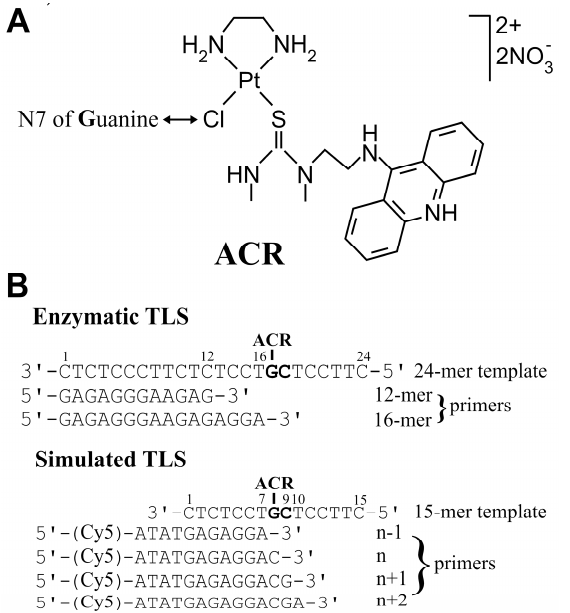
Figure 1. ( A ) Structure of the investigated platinum conjugate ACR, [PtCl(en)(L)](NO 3 ) 2 (en = ethane- 1,2-diamine, L = 1-[2-(acridin-9-ylamino)ethyl]-1,3-dimethylthiourea), and a sketch of the platinum moiety purine coordination site. ( B ) Sequences of DNA oligonucleotides used in this study; G in the template strands represents guanine uniquely modified by the ACR conjugate in the 5 (cid:48) -CG sequence. Enzymatic TLS: 24-mer template (nonmodified or containing the ACR adduct) and primers for “running” or “standing” start polymerization, 12-mer or 16-mer, respectively. Simulated TLS: Set of the sequences of the 15-mer template (nonmodified or containing the ACR adduct) and n − 1, n, n + 1, n + 2 primers where n − 1 indicates the position one nucleotide before the lesion, n—position opposite the lesion, n + 1—position one nucleotide behind the lesion, and n + 2—position two nucleotides behind the lesion caused by ACR. All these primers were labelled by fluorescent dye Cy5 linked to the -ATAT- tail on the 5 (cid:48)